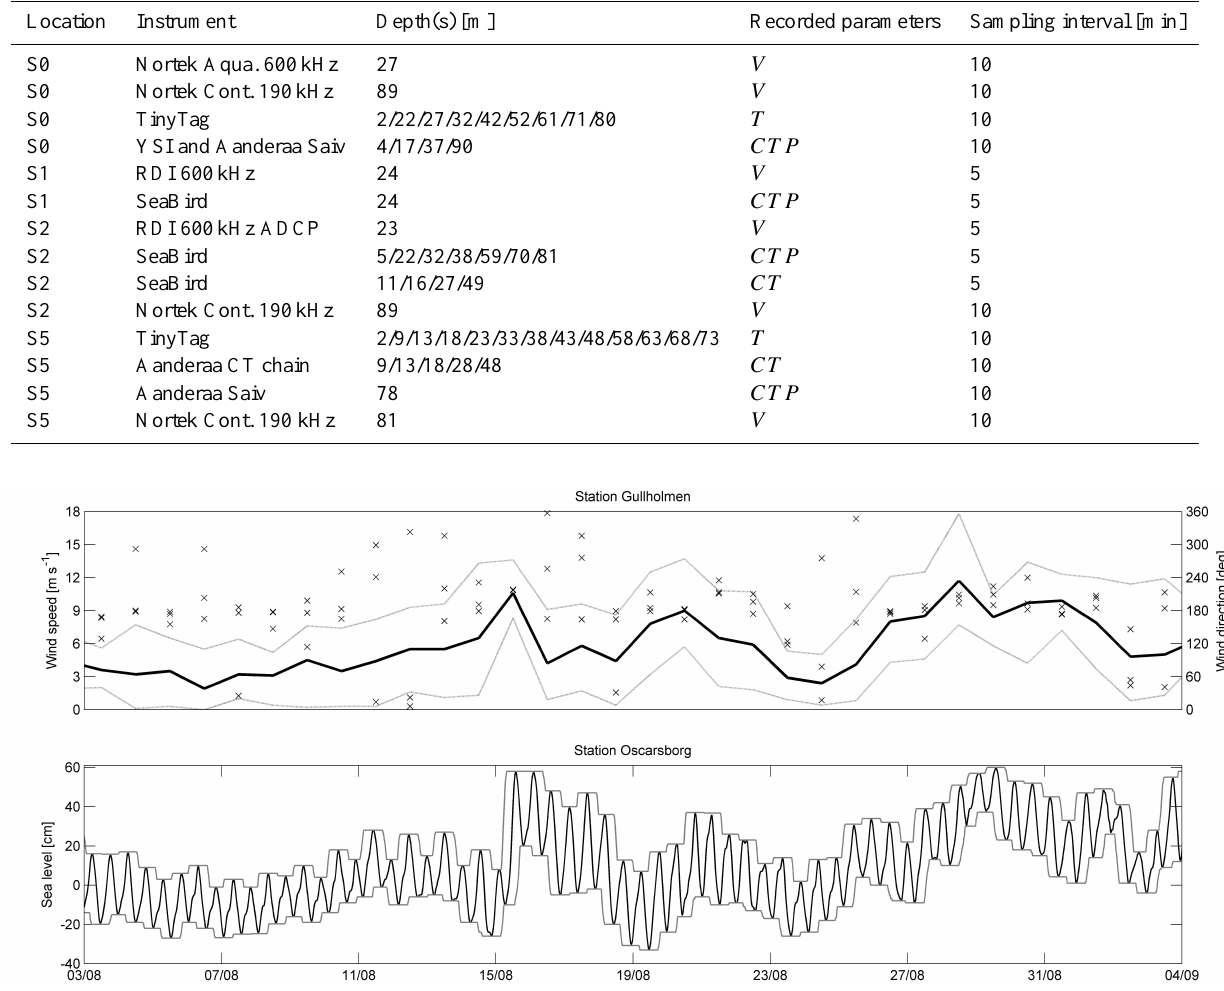
Fig. 3. (a) The wind conditions at the station Gullholmen approximately 26km south of the Drøbak Sill. The thick black line represents the diurnal mean wind speed, the dotted lines the diurnal maxima andminima of the speed, and the crosses mark the wind directions. (b) Surface elevation measured at the station Oscarsborg close to S2 (black line). Grey lines indicate the 1 and 99 percentile elevations of the sea surface during a tidal cycle. These elevations are used in Eq. (5) to calculate the amplitude of the surface elevation.